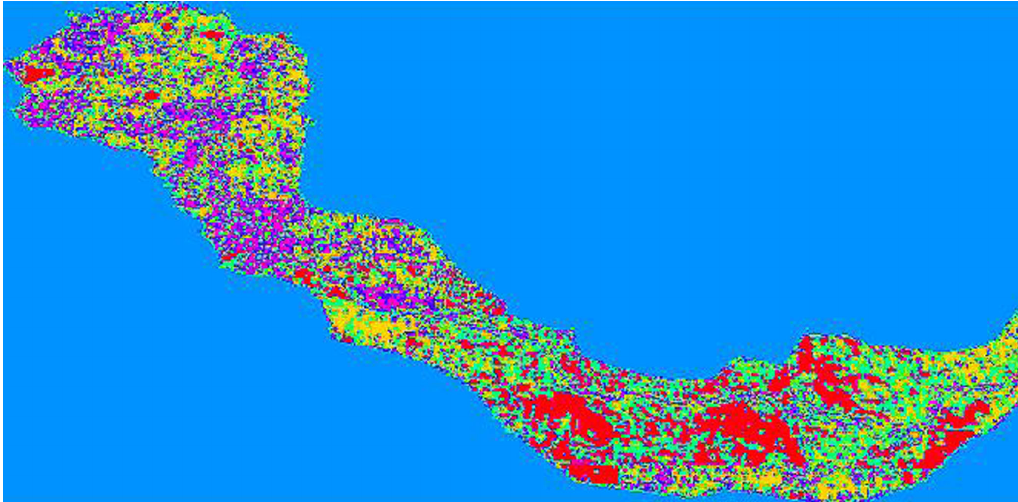
Figure 6: Remote sensing image segmentation of Ajoy river catchment area obtained by FCM algorithm (for